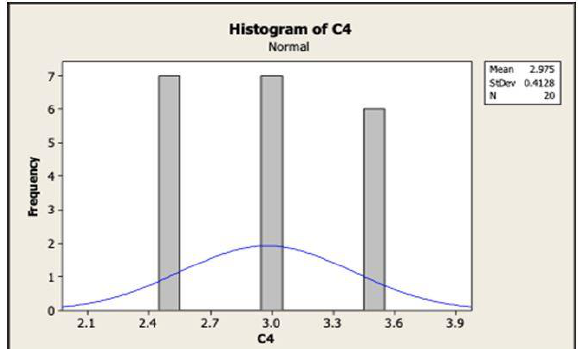
Fig. 4: Normal distribution at confidence level 95% for Virus titer by using tissue culture (TC).